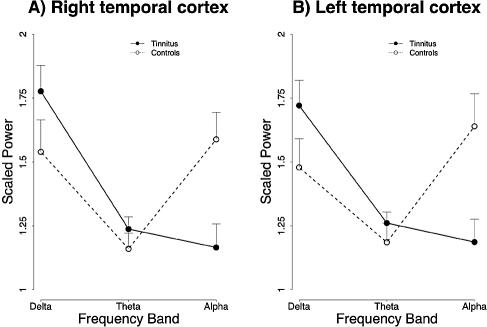
Display of the Group × Frequency Band Interaction Effects Averaged over Temporal SourcesEffects for right (A) and left (B) temporal cortex, where the strongest enhancements of alpha and reductions of were found.